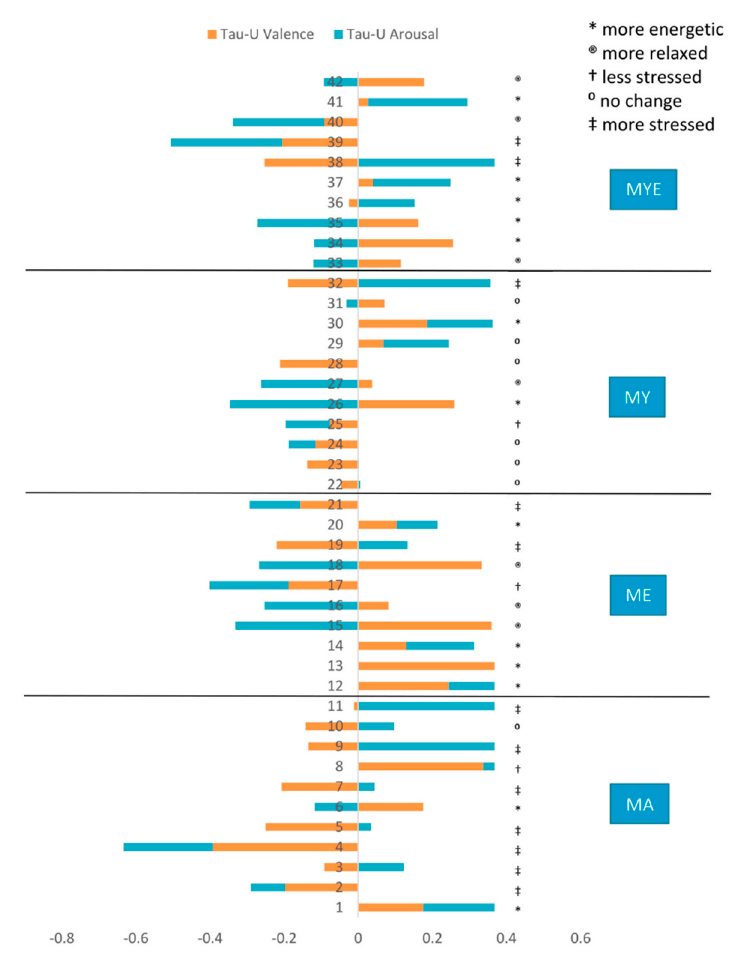
Figure 8. Stacked bar chart of Tau- U valence and arousal estimates with qualitatively classified affective responses per participant. Note . Numbers denote participants; MA = mantra meditation only; ME = meditation and ethical education; MY = meditation and physical yoga; MYE = meditation, physical yoga, and ethical